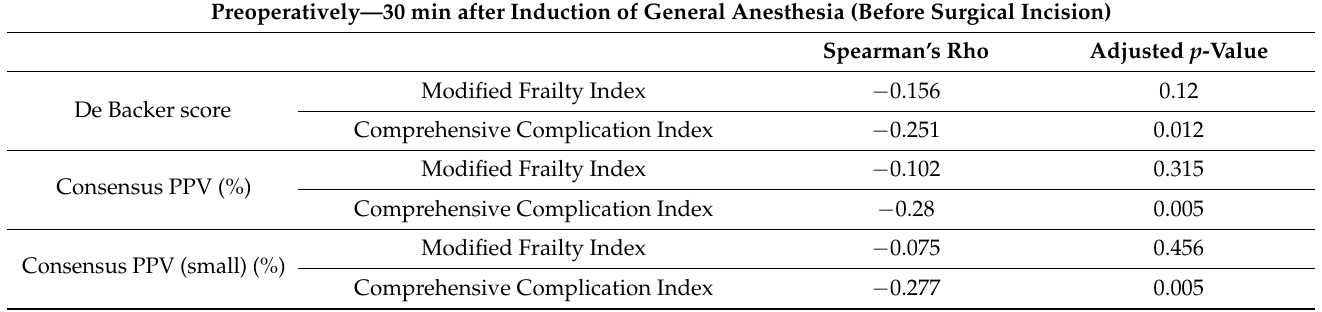
Table 3. Correlation of microcirculation variables with morbidity and mortality scores.